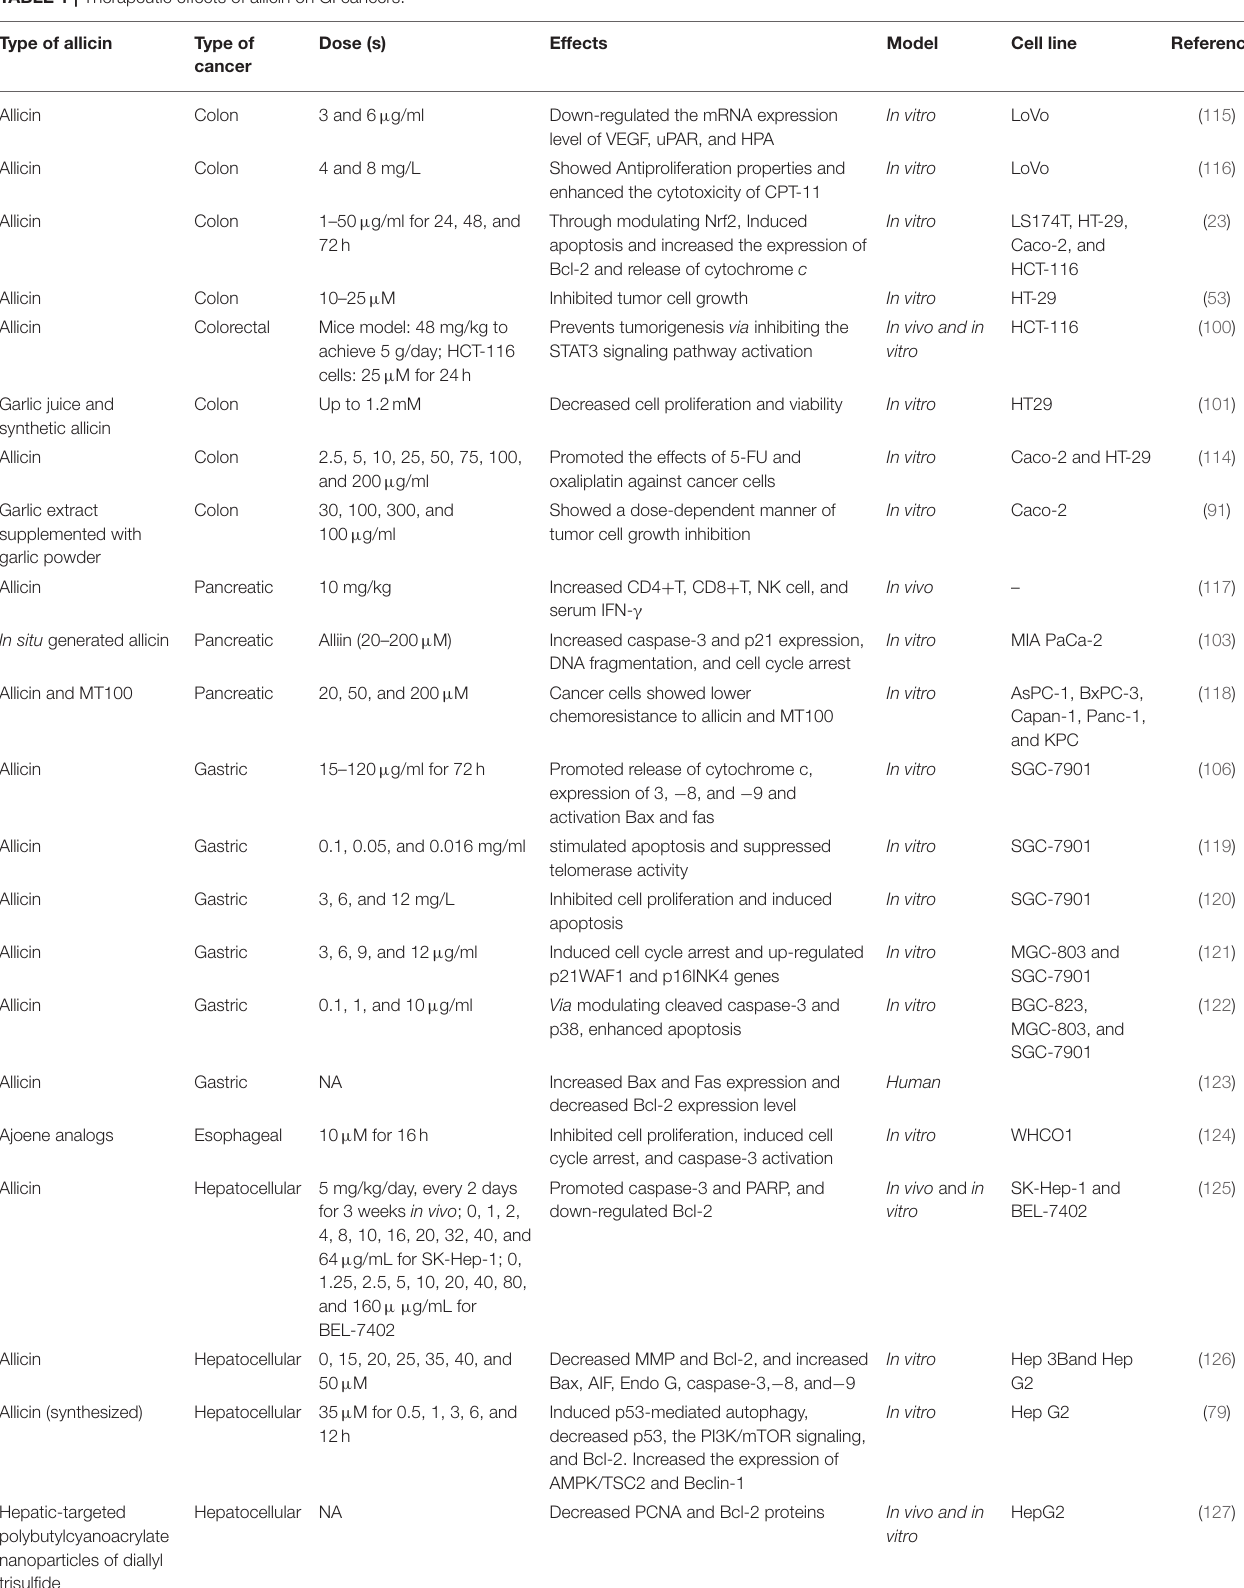
TABLE 1 | Therapeutic effects of allicin on GI